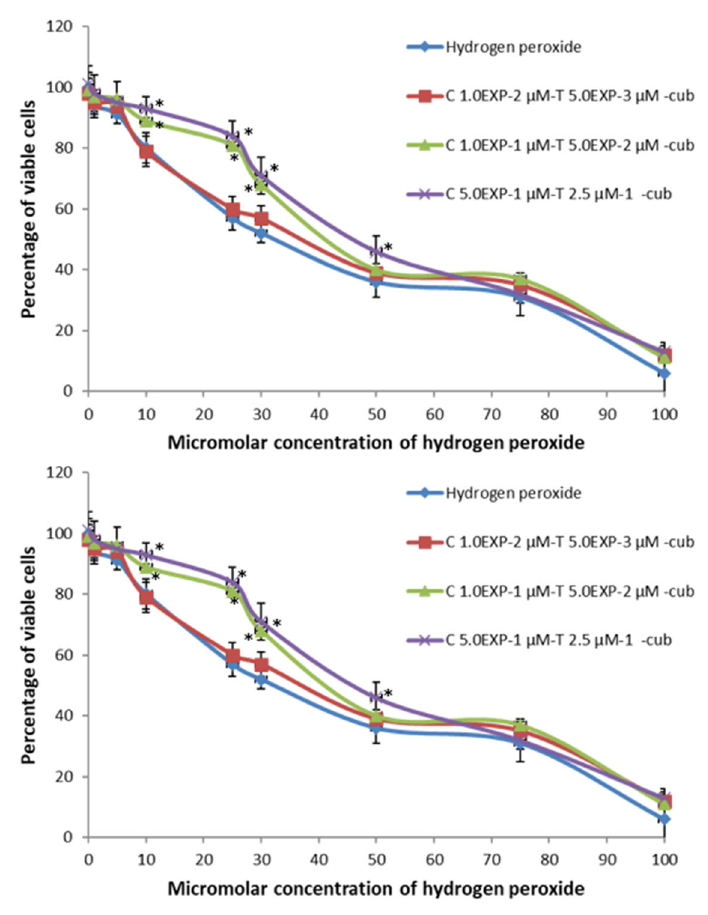
Figure 6. Top to bottom, antioxidant activity of CT-cub, CP-cub, see Table S2 in Supplementary Materials for concentration and EE% values. * Values are statistically different versus hydrogen peroxide p < 0.05.